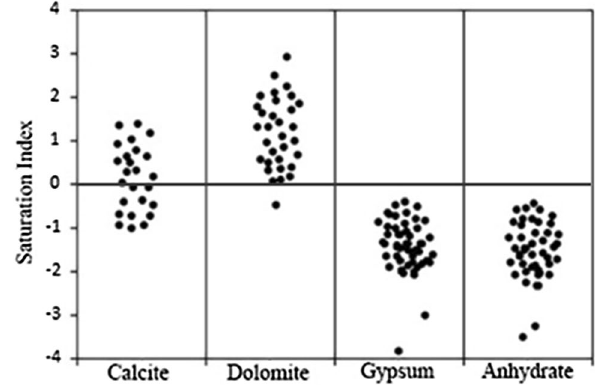
Fig. 6 Plots of saturation indices with respect to calcite, dolomite, gypsum, and anhydrate